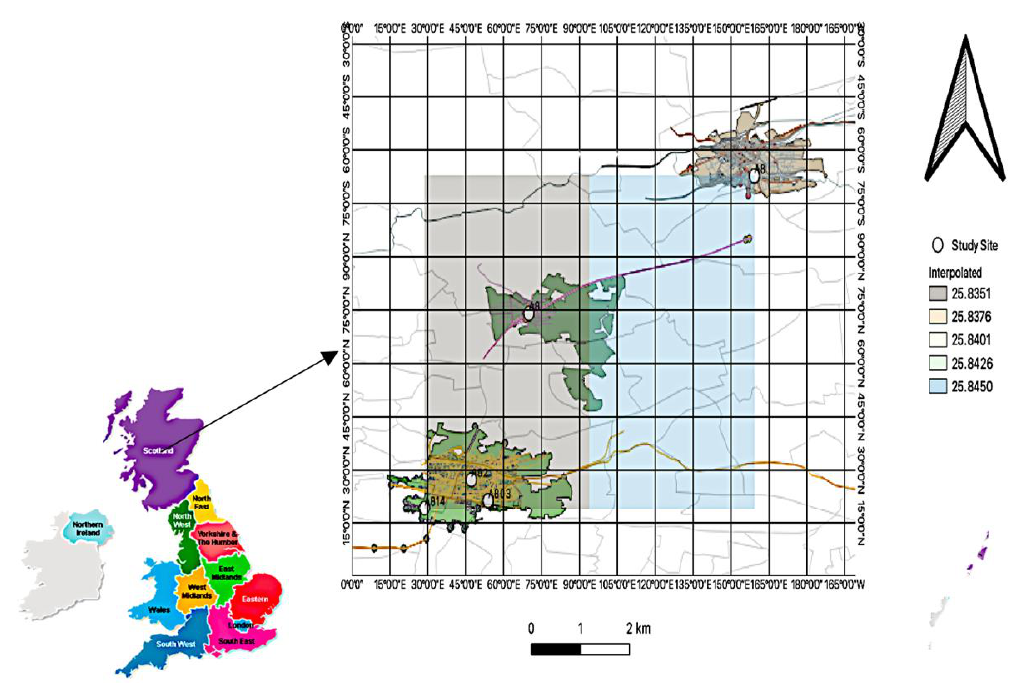
Figure 1. Map of study area. The maps were created using the QGIS 3.24.3-Tisler software (Open Source Geospatial Foundation Project, Chicago, USA).